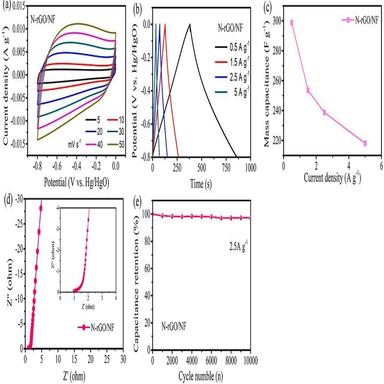
(a) The CV curves of N-rGO/NF, (b) The GCD curves of N-rGO/NF, (c) The specific capacitance vs. current densities, (d) Nyquist plot of N-rGO/NF, (e) Cycle performance of N-rGO/NF.